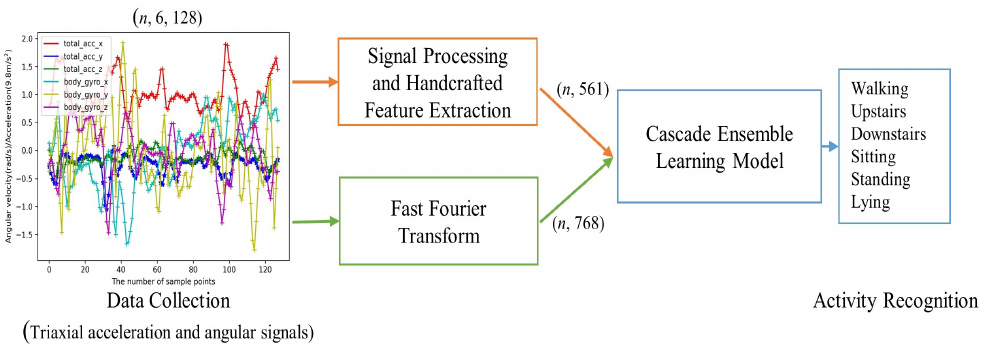
Figure 1. Overview of HAR system. Handcrafted feature extraction based HAR contains data collection, signal processing, feature extraction and CELearning model. Automatic feature extraction based HAR contains data collection, FFT and CELearning